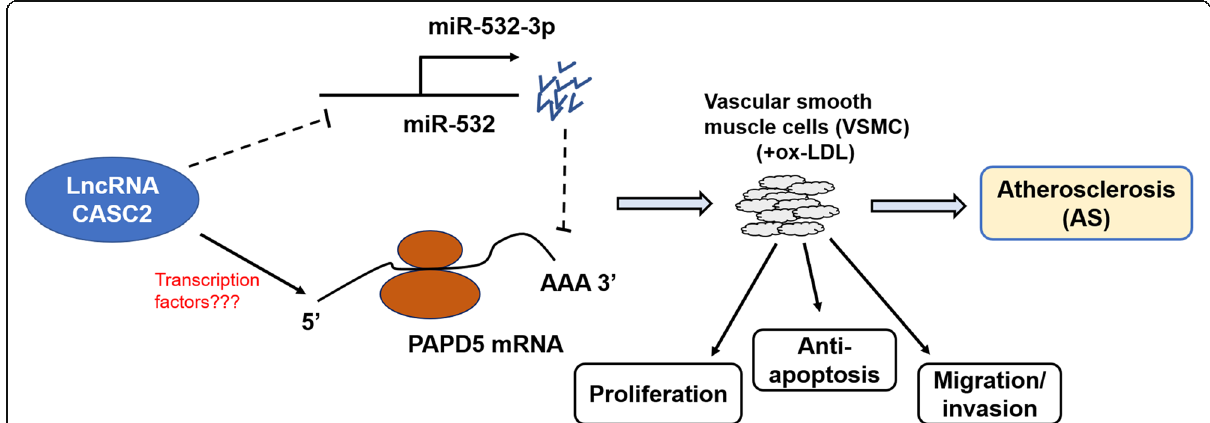
Fig. 6 The schematic model of relationships between CASC2 regulating miR-532-3p/PAPD5 in the pathogenesis of atherosclerosis (AS). In the model of VSMC treated with ox-LDL, lncRNA CASC2 could compete with miR-532-3p by regulating PAPD5 participate in the proliferation and migration of VSMC, which suggest its critical roles in the pathogenesis of